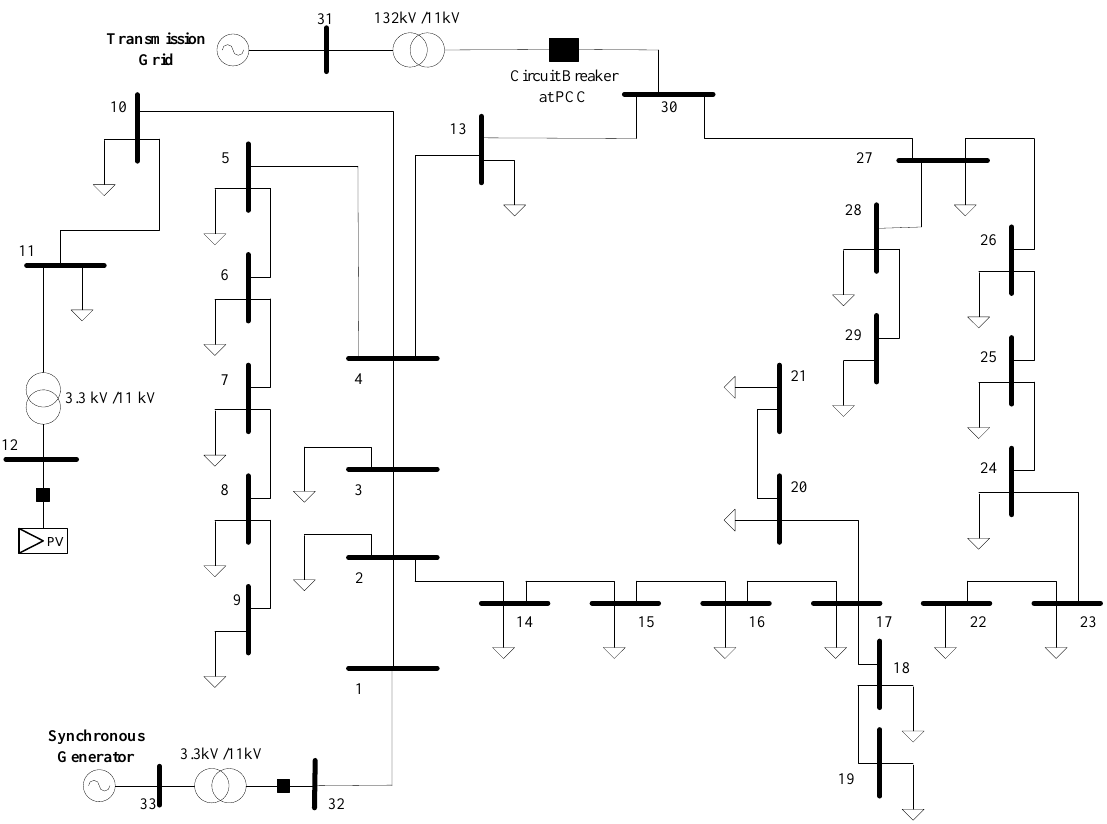
Figure 5. Single line diagram of the test system model.